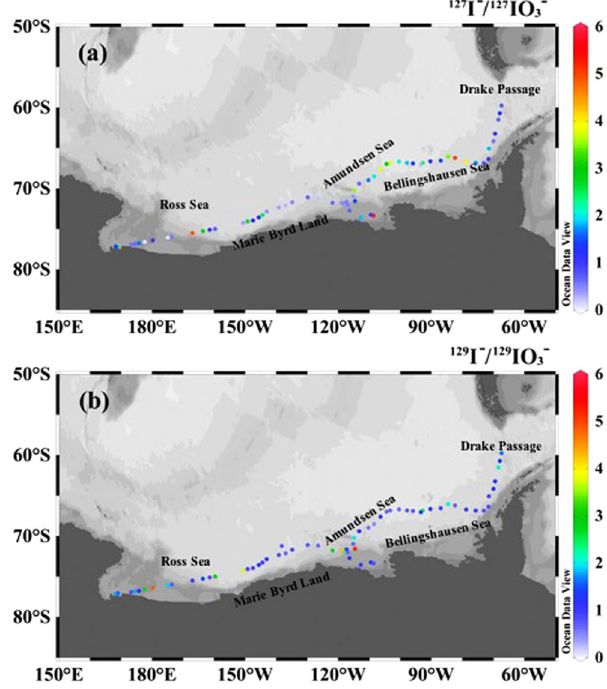
Figure 2. Variation of 129 I − / 129 IO 3 − and 127 I − / 127 IO 3 − molar ratio in Antarctic surface seawater. The original map was constructed by a free software Ocean Date View (ODV 4.7.8) (Schlitzer, R., Ocean Data View, odv.awi. de,